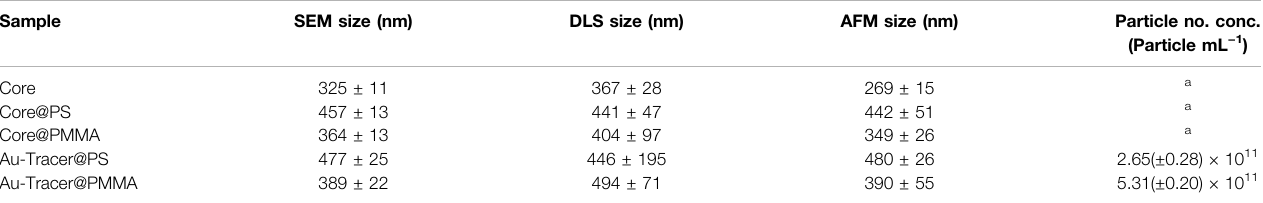
TABLE1| Measuredsizesofcore,shelled,andtracermaterialsusedinthisstudy.StockparticlenumberconcentrationsweredeterminedusingsingleparticleICP-MS.Data represents the average and standard deviation, excepting DLS where the error represents the width of the size distribution. Sample